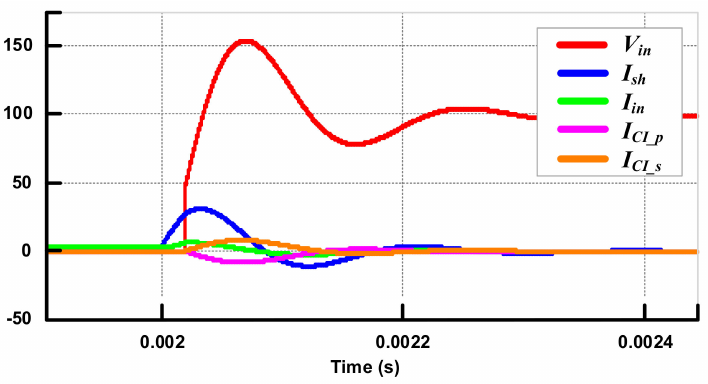
Figure 4. Key waveforms of simulation